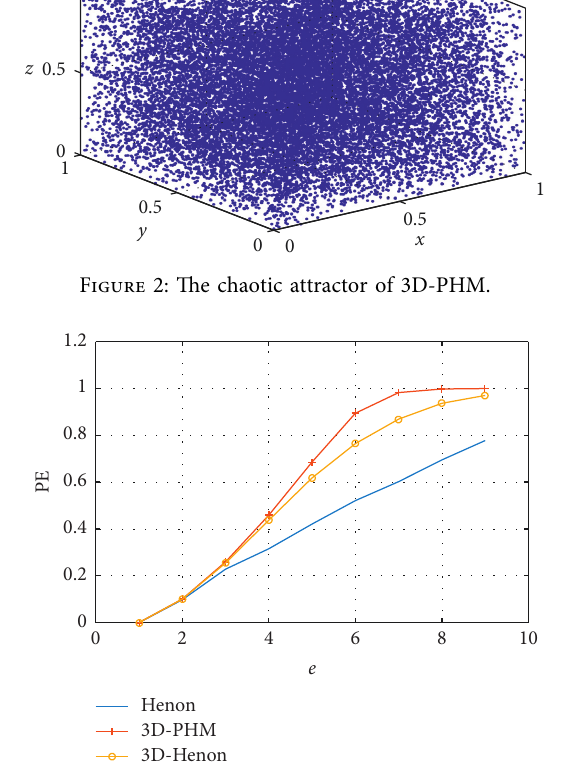
Figure 3: The comparison of PE between Henon mapping, 3D-PHM, and 3D-Henon mapping ( e is the embedded